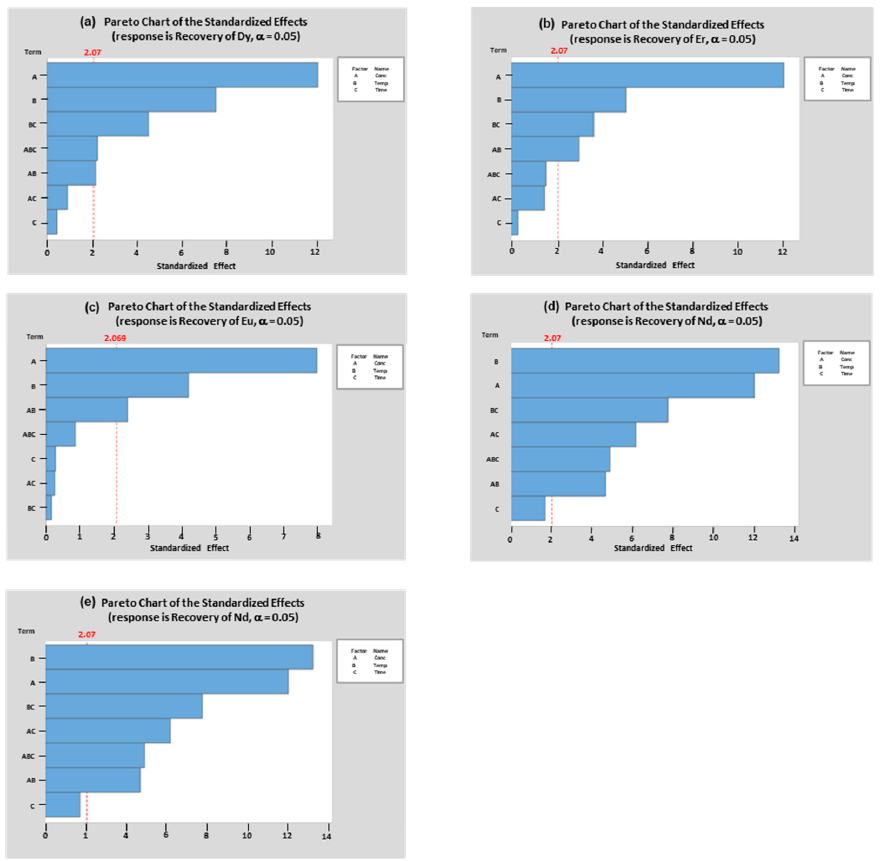
Figure 6. Pareto charts of the standardized effects for individual critical REEs. Table 12. Fit statistics for the Extraction Models of critical REEs.